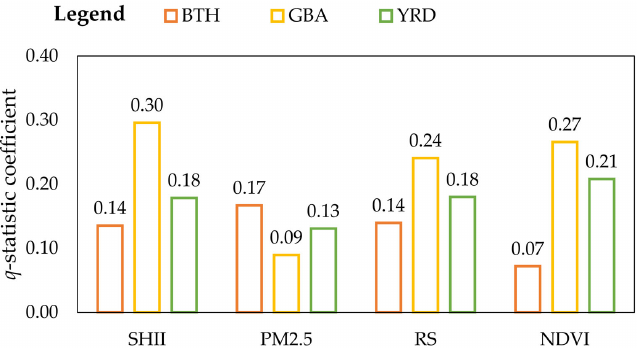
Remote Sens. 2023 , 15 , 921 Figure 14. The q ‐ statistic coefficients for the grading indicators in the three UAs. Figure 14. The q -statistic coefficients for the grading indicators in the three UAs.